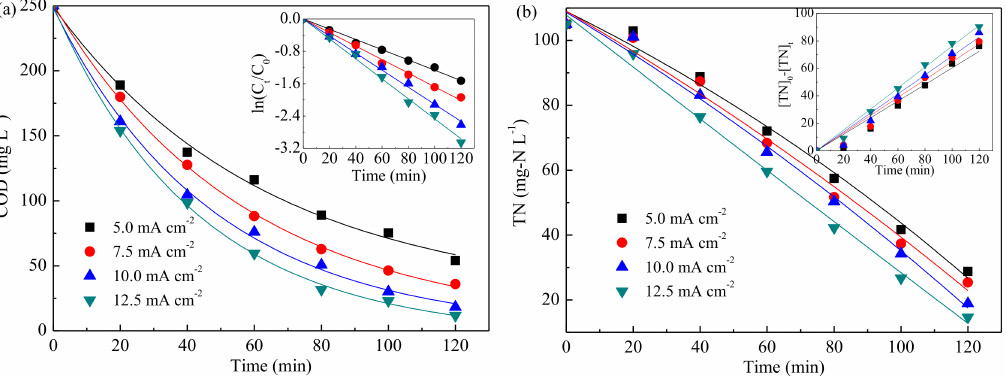
Figure 5. Effect of current density on COD ( a ) and TN ( b ) removal. (pH = 6, 1000 mg L − 1 Cl −